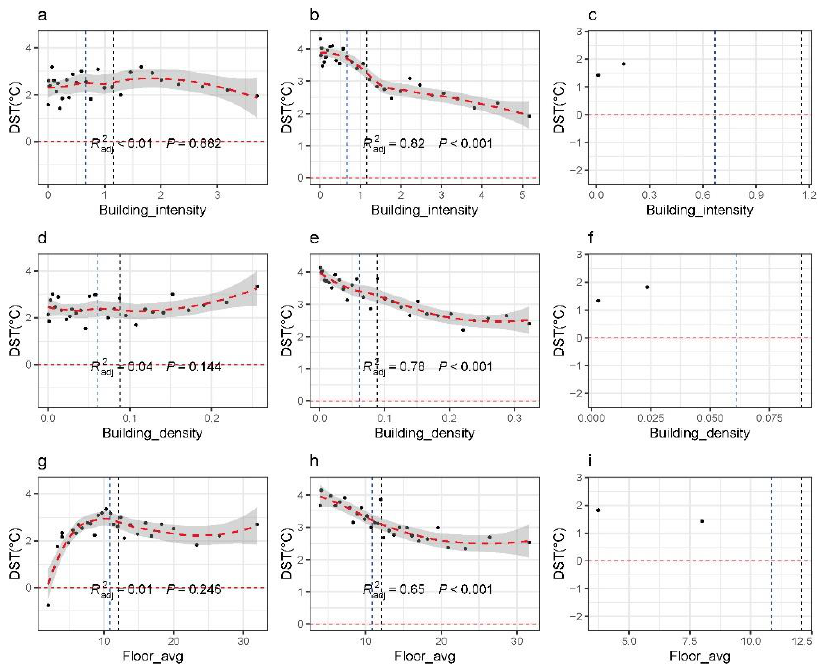
Figure 10. Single-factor scatter plots and fitting curves of DST to three surface building indicators. Subgraphs ( a , d , g ) are for the group of functions for A, G and R; ( b , e , h ) are for the group of functions for B, M, S and W; ( c , f , i ) are for Non-construction areas. The vertical blue dotted line is the median value and the black one is the mean value of the corresponding independent variables; the horizontal red dotted line is the zero value of DST.